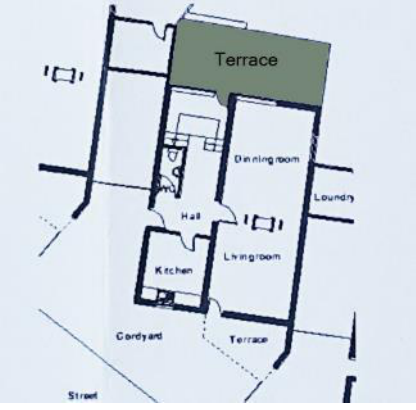
Figure 12. Efruz Mass House, Orientation toward North (Image by Author from CartoDB GIS system).